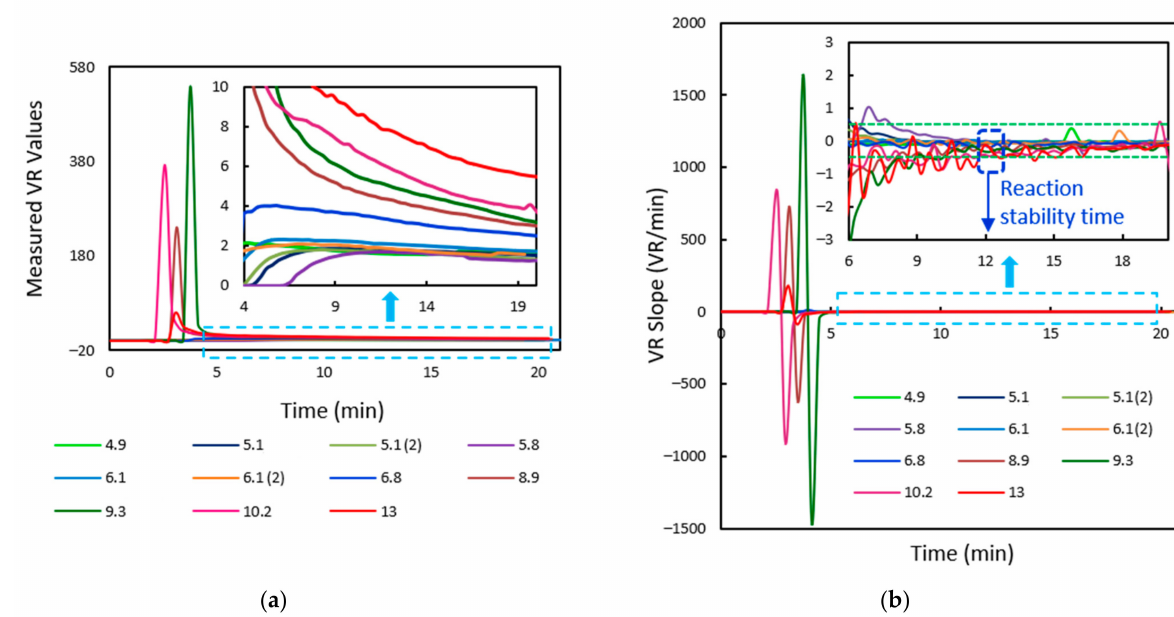
Figure 17. ( a ) The volume ratio values measured for 10 HbA1C test cartridges of different concentrations. The inset image depicts the graph zoomed-in from time t = 4 min to t = 20 min. ( b ) The corresponding trend of change in VR slopes with time, the zoomed-in graph from time t = 6 min to t = 20 min indicated as